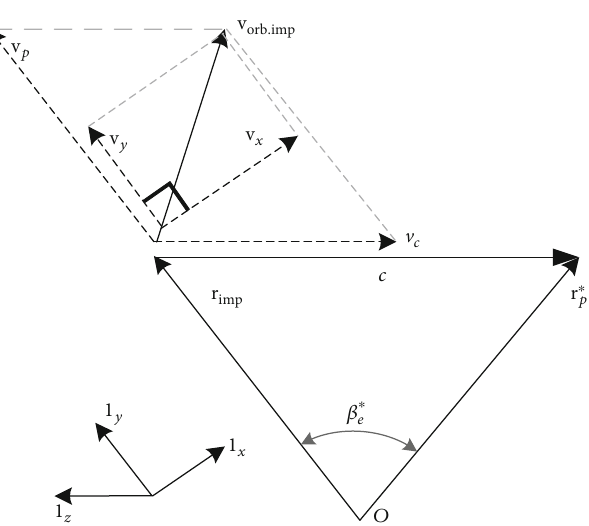
Figure 5: Calculation required velocity vector according to di ff erent velocity